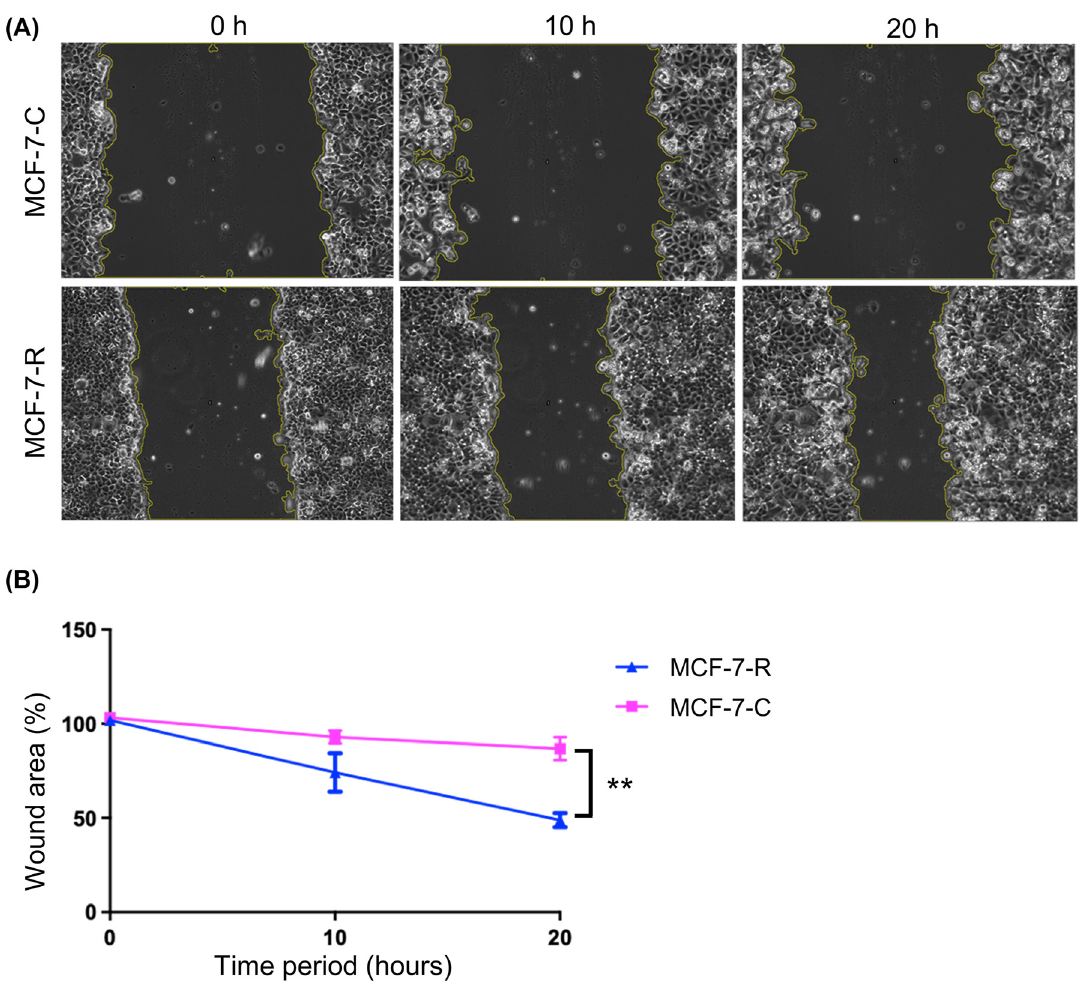
Figure 4: DAPT-resistant MCF-7 cells have increased migration capacity. (A) Time-lapse microscopy images of wound closure of MCF-7-C and MCF-7-R cells 0, 10, and 20 h after the wound formation. Yellow lines indicate the wound area. (Scale bar: 100 μ m). (B) Percentage of open wound area in control and resistant cells. Data represent the means and ± SD of three independent experiments